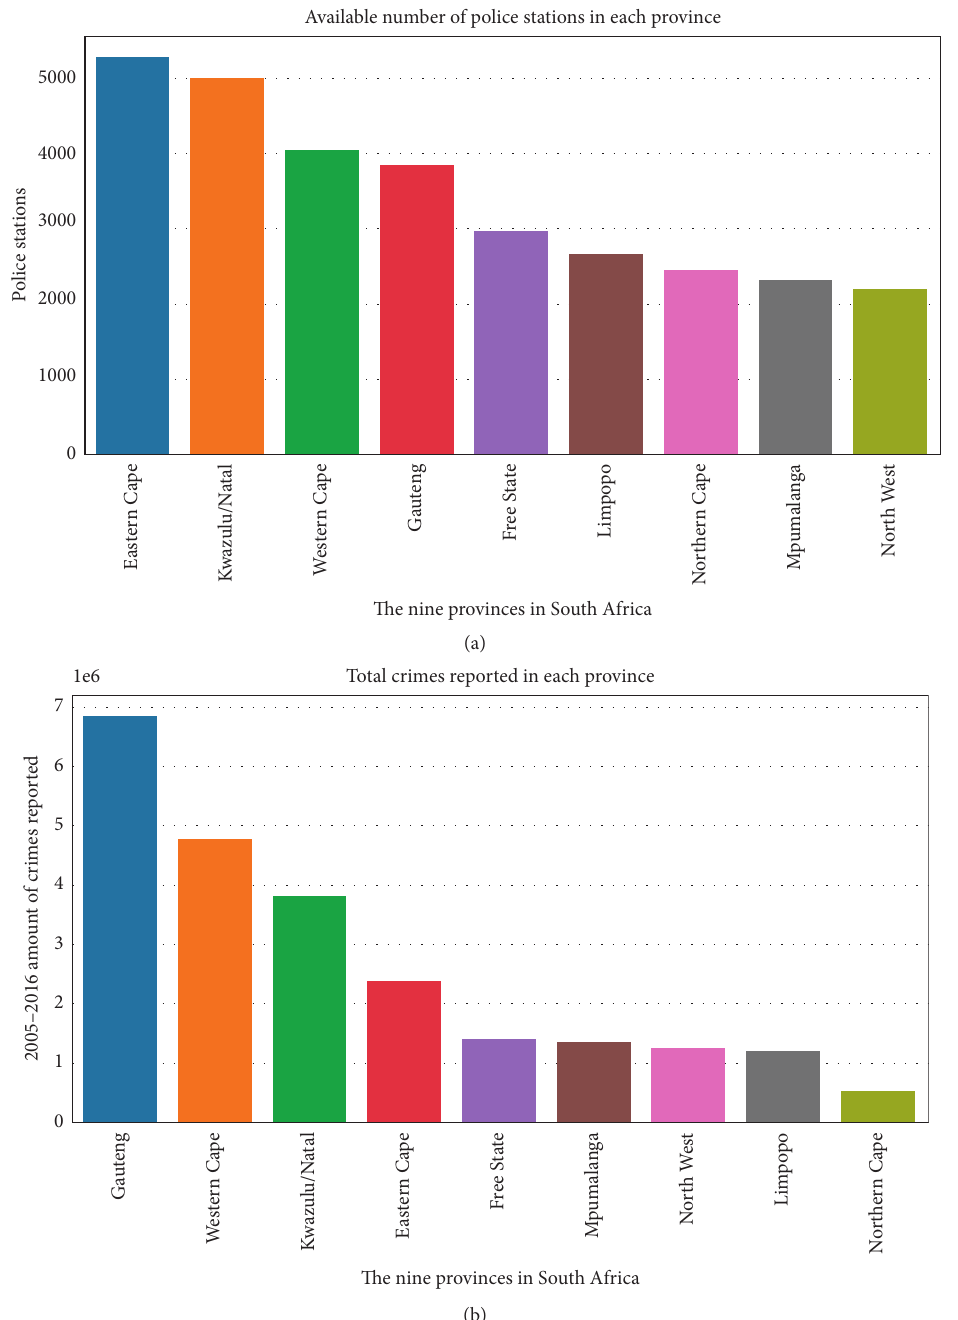
Figure 3: Number of police stations and number of reported crimes in South African Provinces (2005–2016). (a) Number of police stations per province. (b) Total crimes per